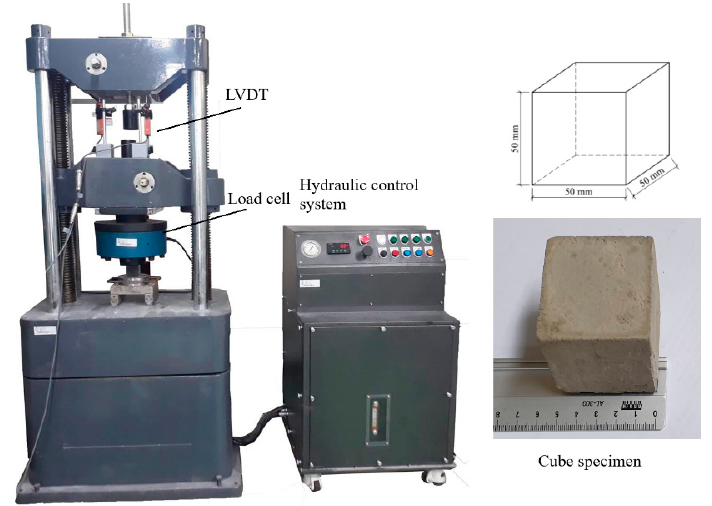
Figure 2. The compressive strength test.